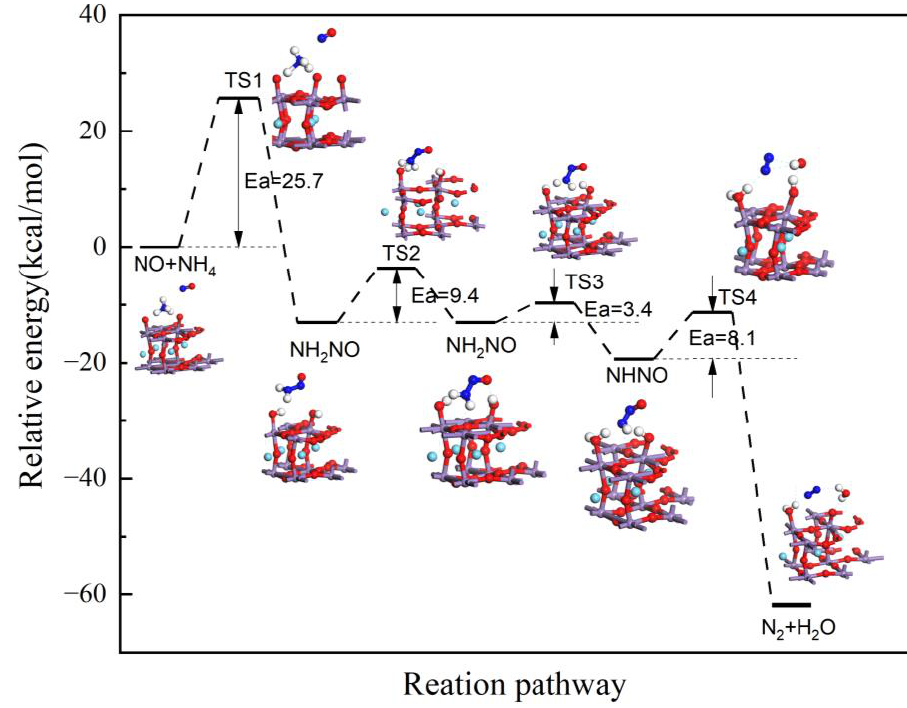
Figure 14. The NH 4+ reaction process in the Figure 13a configuration over the catalyst.